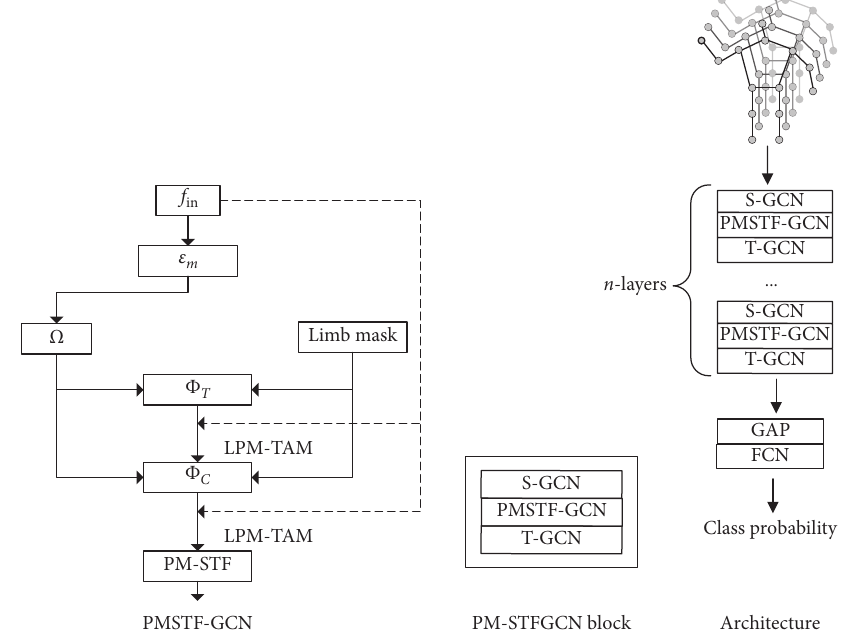
Figure 3: ST-GCN based spatiotemporal fusion graph convolution neural